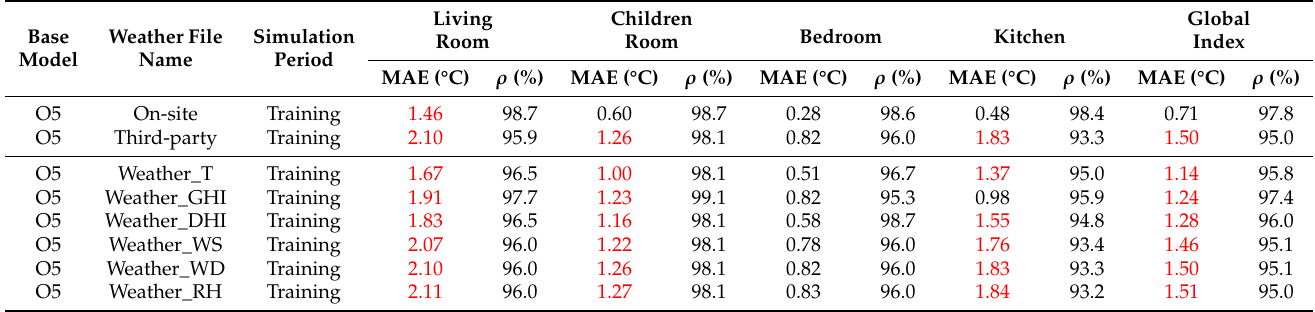
Table A5. MAE and ρ indices per thermal zone in the training period. House O5, base model.